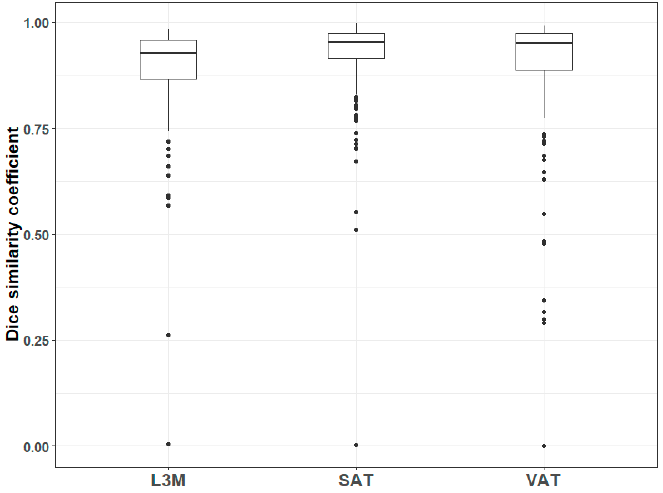
Figure 2. A box and whisker plot illustrating the distribution of Dice Similarity Coefficient (DSC) for the L3 lumbar muscle (L3M), subcutaneous adipose tissue (SAT) and visceral adipose tissue (VAT). The thicker horizontal bar represents the median value, the edges of the box represent the upper and lower 25 percentiles and the thin vertical lines represent the limits of the 1 percentiles. Data outliers beyond these limits have been plotted in the figure as small solid circles.